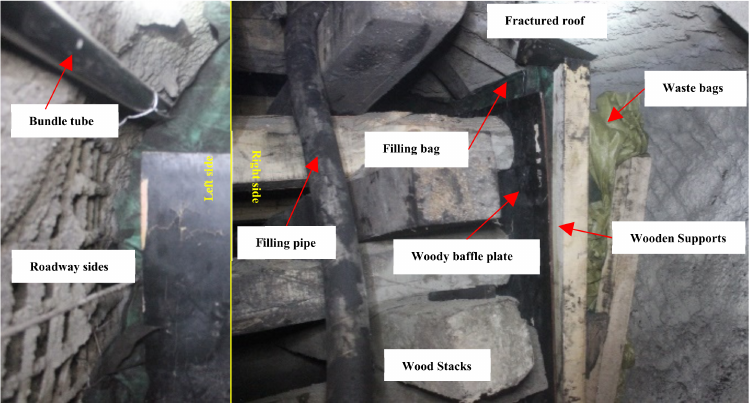
Figure 12. On-site picture of the roof-adaptive end filling technology.